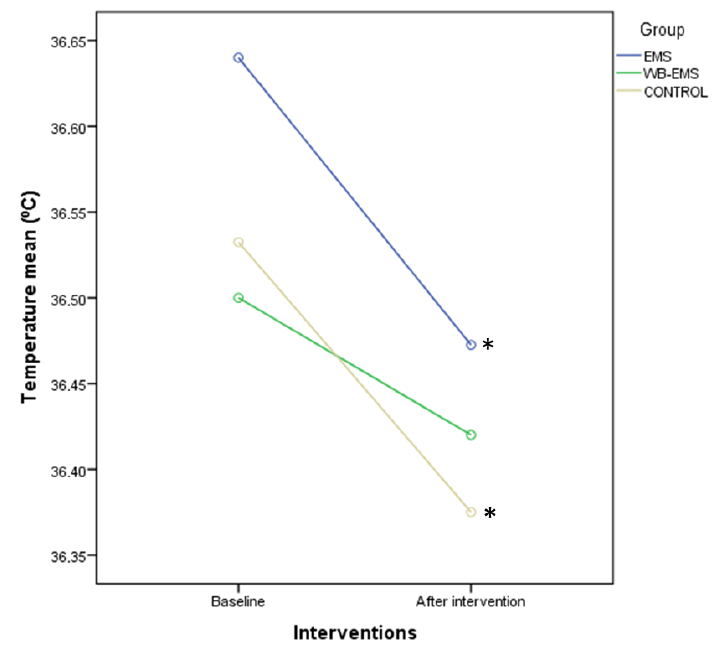
Figure 9. Linear graphs showing temperature means before and after interventions as well as intra- group comparisons among the EMS, WB-EMS, and control groups. Abbreviations: EMS, electrical muscle stimulation; WB-EMS, whole body electrical muscle stimulation. * Intragroup comparisons showed statistically significant differences ( p < 0.05).